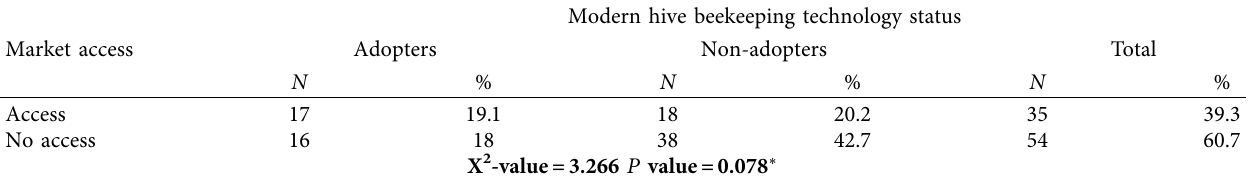
Table 13: Distribution of market access of respondents.